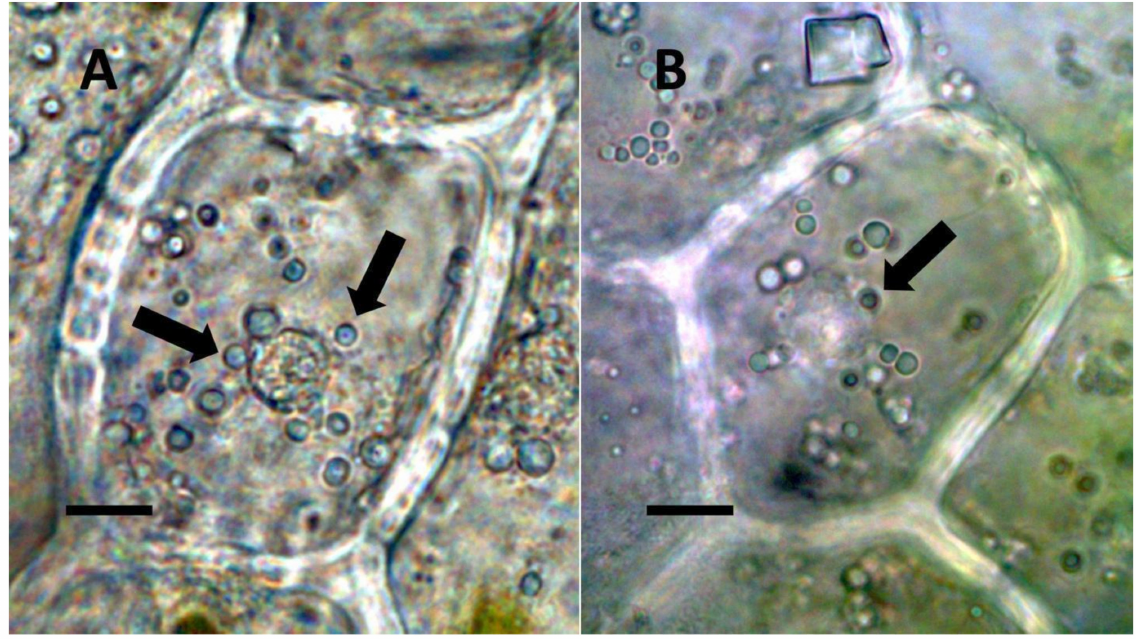
Figure 2. Vanilla phaeantha showing bacteria within and emerging from (arrows) nuclei. ( A ) Nucleus stained with acidified diphenylamine to show nitrate (blue-purple color) (Bar = 10 µ m). ( B ) Nucleus stained with nitro blue tetrazolium to show superoxide (blue color) around bacteria (arrows) emerging from nucleus into cytoplasm (Bar = 10 µ